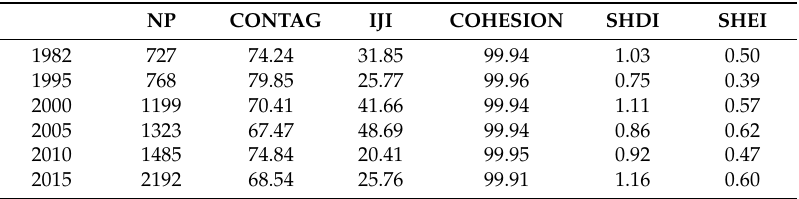
Table 5. Landscape-level metrics for marshlands, paddy fields and dry farmlands in the Naoli River